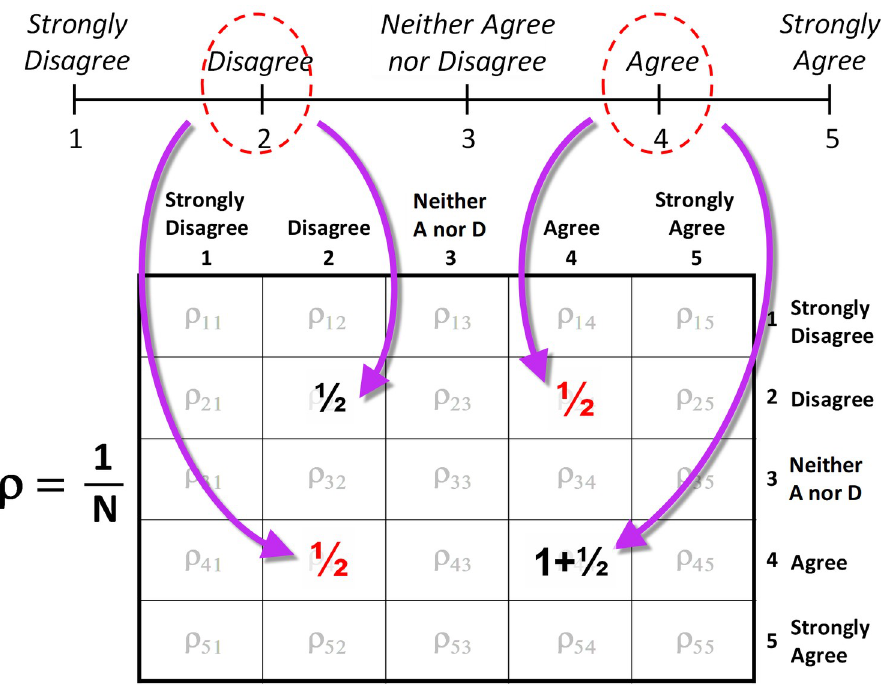
Fig A2. For a double response, a half-count is added to each of the corresponding diagonal array elements, and a half-count to each corresponding off-diagonal element.